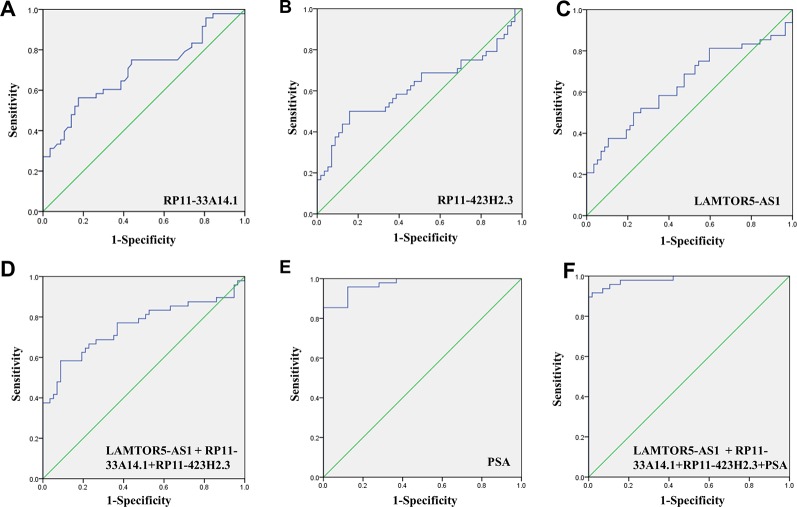
ROC curve showing expression levels of differentially expressed long non-coding RNAs (DelncRNAs). LncRNA RP11-33A14.1 (A), RP11-423H2.3 (B), and LAMTOR5-AS1 (C) in prostate cancer (PCa) patients and benign prostatic hyperplasia (BPH) controls; the three lncRNAs combination (D); prostate-specific antigen (PSA) only (E); and the three lncRNAs and PSA combination (F). The receiver operating characteristic (ROC) curves were analyzed using univariate (log-rank) analysis.